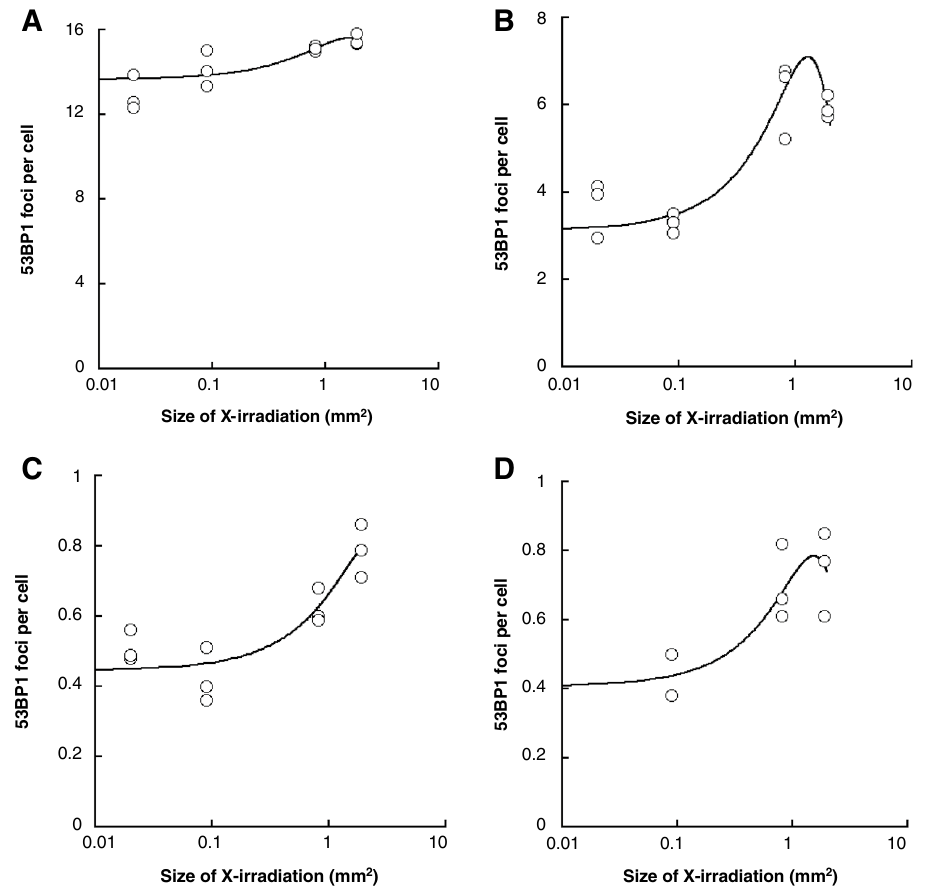
Figure 2. Effects of X-irradiated field sizes on the DNA damage response. The cells were irradiated with 1 Gy of X-rays at a dose rate of 0.25 Gy/s. The number of 53BP1 foci as DSB per cell was measured at 1 h ( A ), 4 h ( B ), 24 ( C ) and 48 h ( D ) post-irradiation. The data were obtained from three or four independent experiments and the mean values for each experiment were plotted. Open circles indicate the number of 53BP1 foci per cell in X-irradiated cells. The change in the number of 53BP1 foci depending on the field size were plotted with the best estimates (solid line) using the generalized linear models. These figures were created with KaleidaGraph